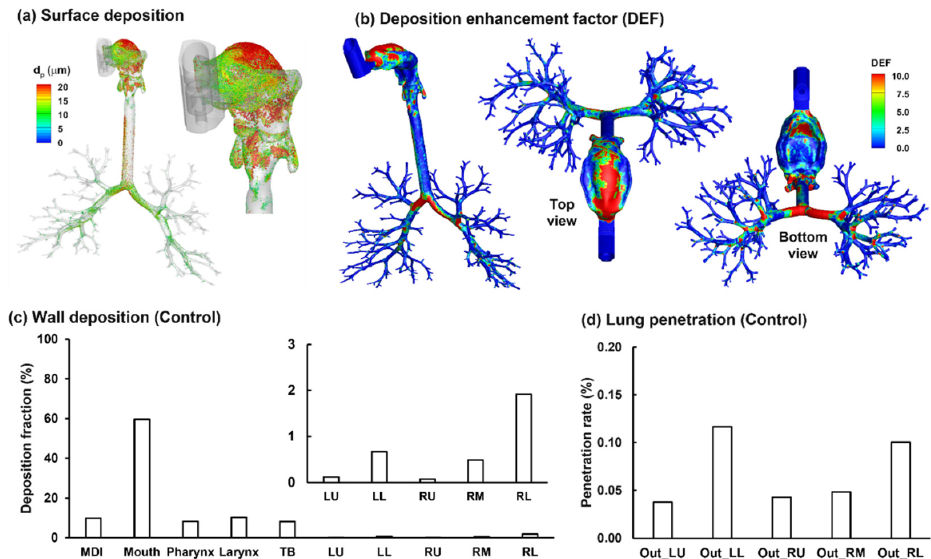
Figure 8. Characterization of the albuterol MDI delivery: ( a ) surface deposition with droplets scaled and colored by the droplet size, ( b ) dose distribution in terms of the deposition enhancement factor (DEF), ( c ) mass-based deposition fraction in different regions of the respiratory tract, and ( d ) drug fraction penetrating beyond the G9 bronchioles (i.e., the penetration rate).